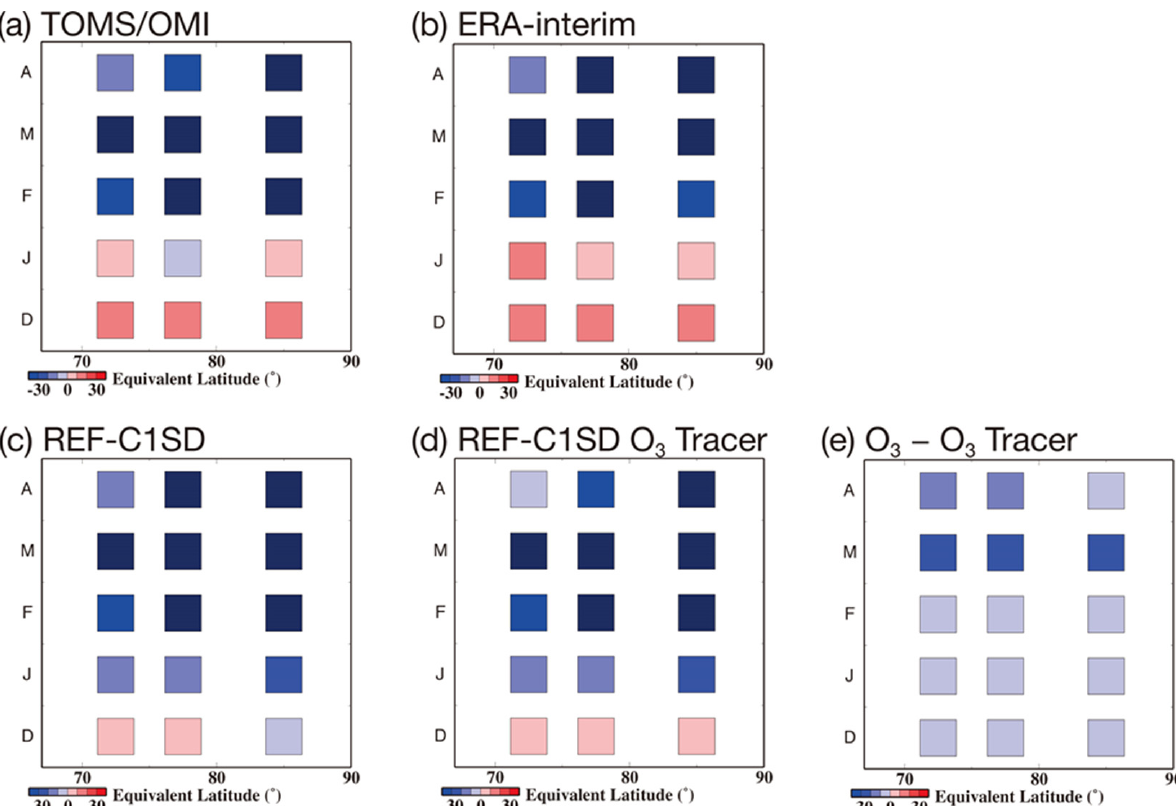
Figure 13. Same as Figure 7 but for the anomalies in 2011 (December 2010–April 2011). Figure 14 shows considerably large negative transport anomalies in the polar strato- sphere in February and March (the middle and bottom panels of the second column). The negative transport anomalies are consistent with the residual mean circulation anomalies in the polar stratosphere, which show positive anomalies of the vertical wind (Figure 9h,i). The bottom panel of the third column indicates large negative chemical anomalies within the equivalent latitudes of 70–90 ◦ N between 50 and 80 hPa, which resulted in the large negative total ozone anomalies in March, as shown in Figure 13. The temperature shows significantly large negative anomalies in the polar stratosphere in February and March. The chemical ozone tendency anomalies in February and March (the middle and bottom panels of the fifth column) show the same sign as that of the temperature anomaly in the lower stratosphere and the opposite sign in the middle stratosphere, as expected from the temper- ature dependence of the chemical ozone production/destruction in these regions. Finally, as shown in the middle and bottom panels of the sixth column, the difference between the chemically active ozone and the passive ozone tracer in February and March are repro- duced by the anomalies in the previous months, i.e., January and February, respectively, especially at the levels of 30–100